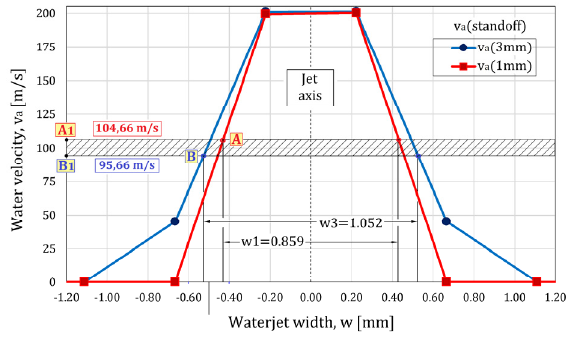
Figure 12. Cutting velocity diagram